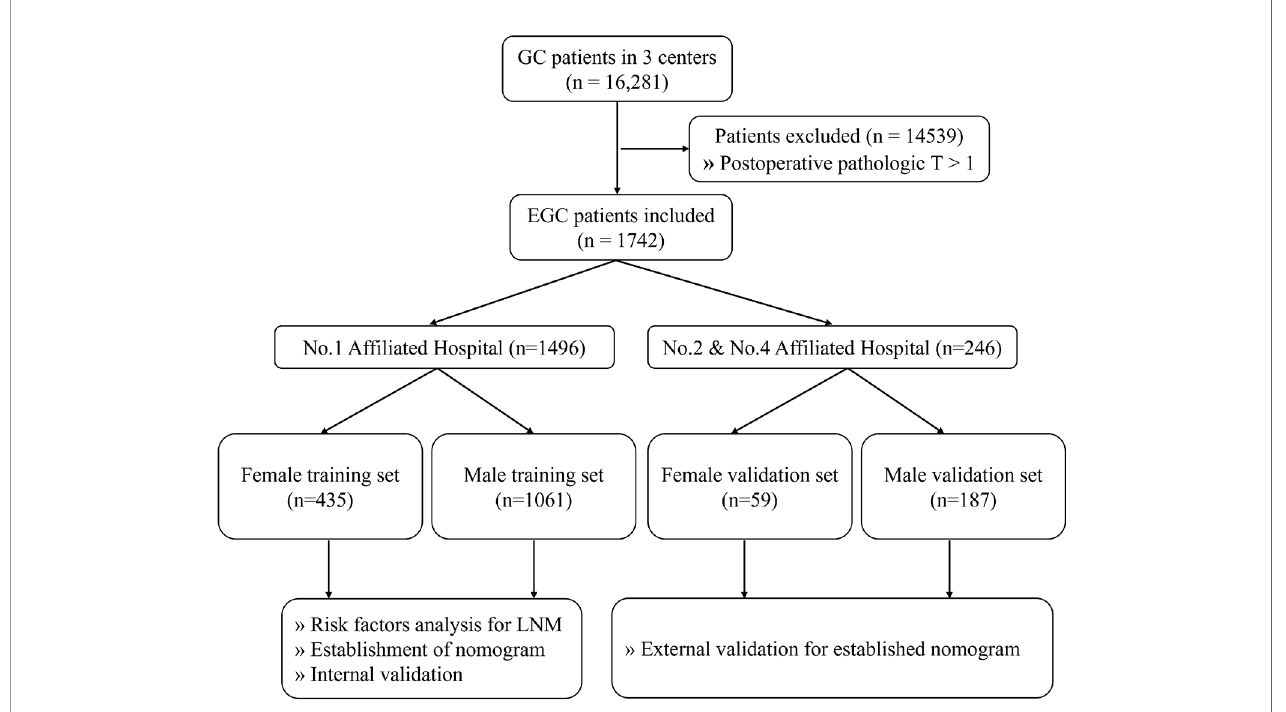
FIGURE 1 | The fl owchart of data collection and grouping for patients with EGC. EGC, early gastric